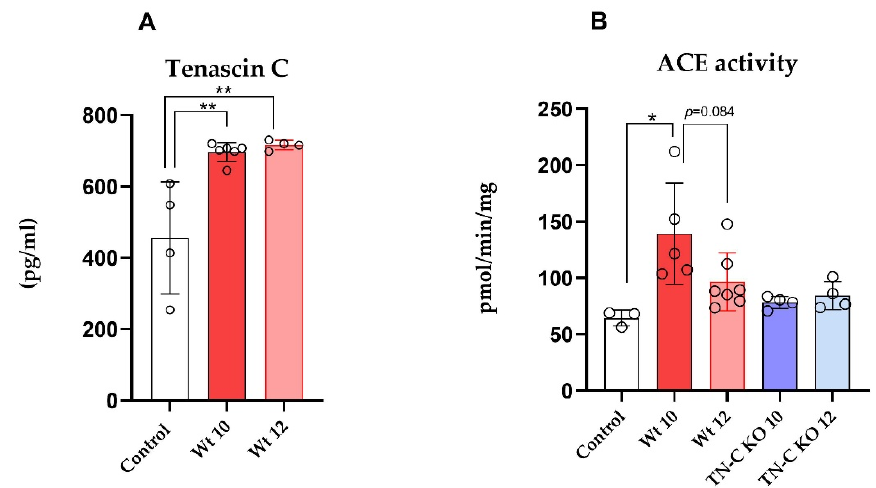
Figure 4. ( A ) Tenascin C (TN-C) levels in left ventricular tissue in control, AJ mice after 10 weeks of banding (Wt 10), and 2 weeks of debanding (Wt 12). ( B ) Angiotensin-converting enzyme (ACE) activity in cardiac tissue in control, Wt, and TN-C KO mice at representative timepoints of banding (10 weeks) and debanding (2 weeks). * p < 0.05, ** p < 0.01, n = 3–7/group. Wild-Type 10 weeks (Wt 10), Wild-Type 12 weeks (Wt 12), Tenascin-C knockout 10 weeks (TN-C KO 10), and Tenascin-C knockout 12 weeks (TN-C KO 12) mice.